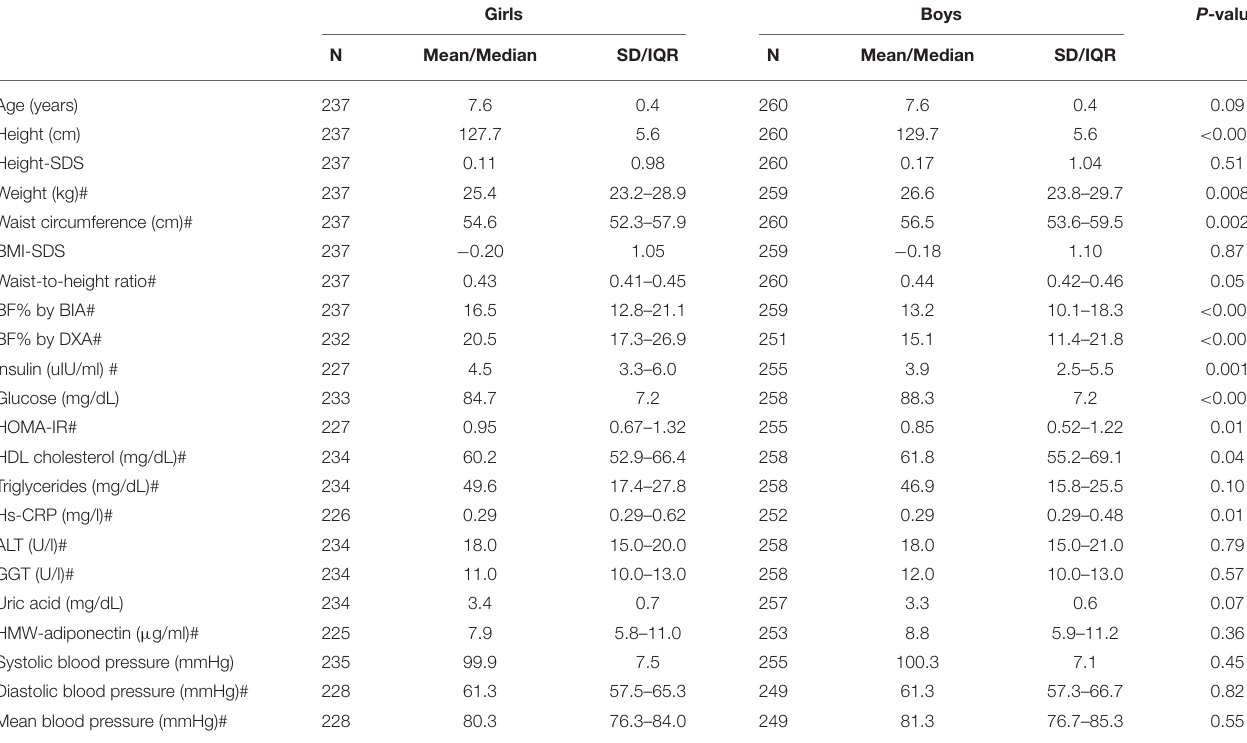
TABLE 2 | Characteristics of